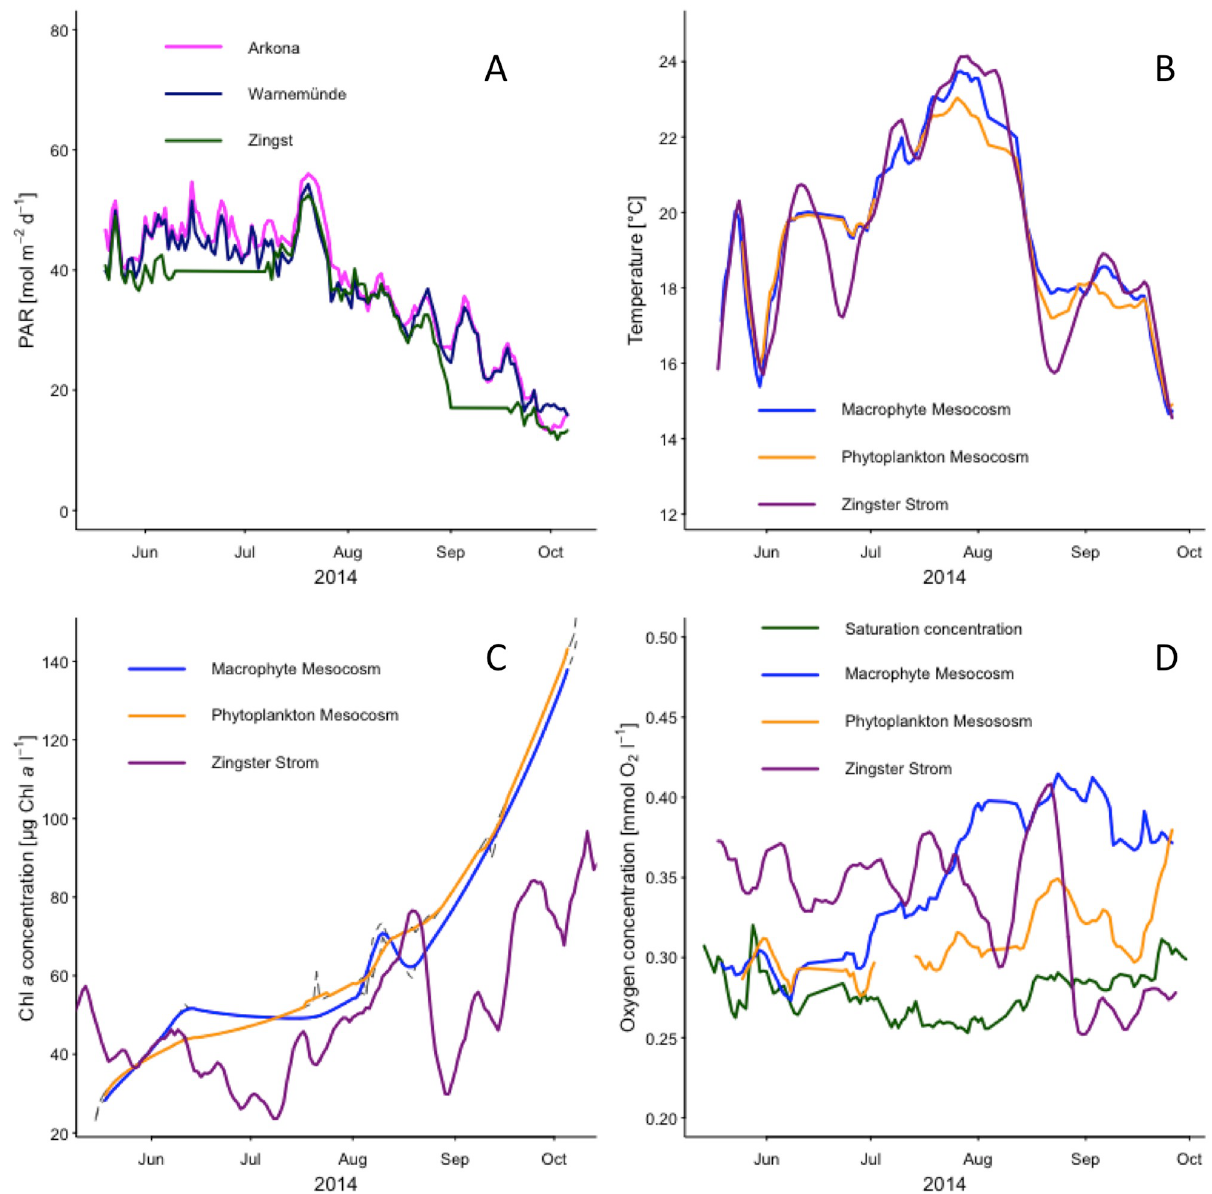
Fig 1. Time series of photosynthetic active radiation (PAR), temperature, chlorophyll a (Chl a ) and oxygen concentration. PAR and Chl a concentration, temperature and oxygen concentration are shown as daily average. Solid lines represent weekly running means fitted to oxygen concentration in mesocosm with (blue line) and without (orange line) macrophytes and the Zingster Strom (magenta line). The green line represents the oxygen saturation concentration.